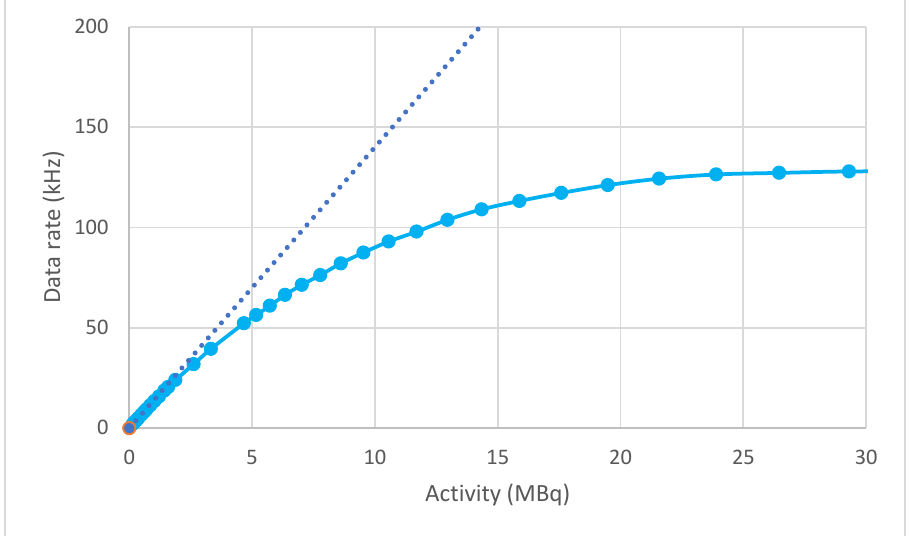
Figure 5 . Coincidence data rate recorded from the ADAC Forte for a central 11 C source of varying activity. The dotted line corresponds to a sensitivity of 1.4%.